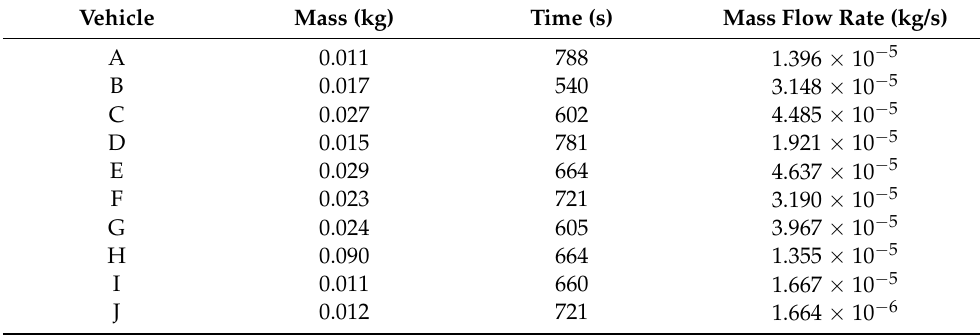
Table 4. Flow rate in seconds calculated based on the experimentally collected data.